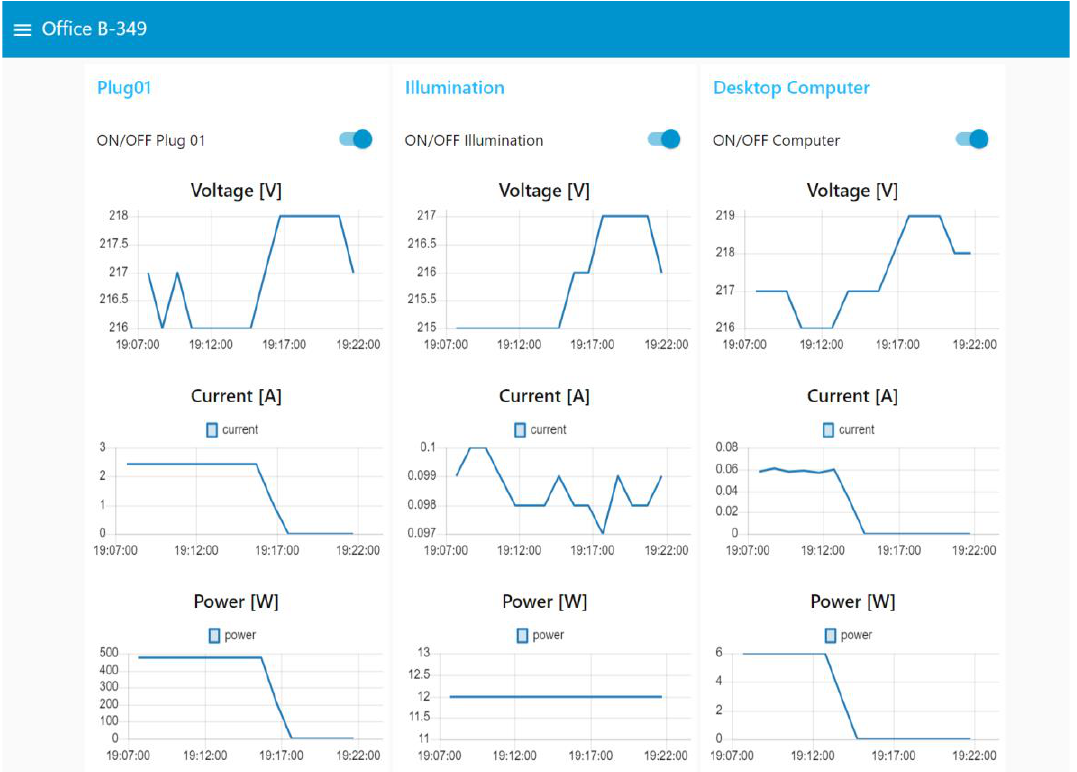
Figure 11. Real-time monitoring data from an office